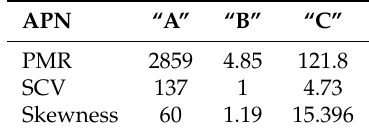
Table 4. Basic statistical comparison of the APN